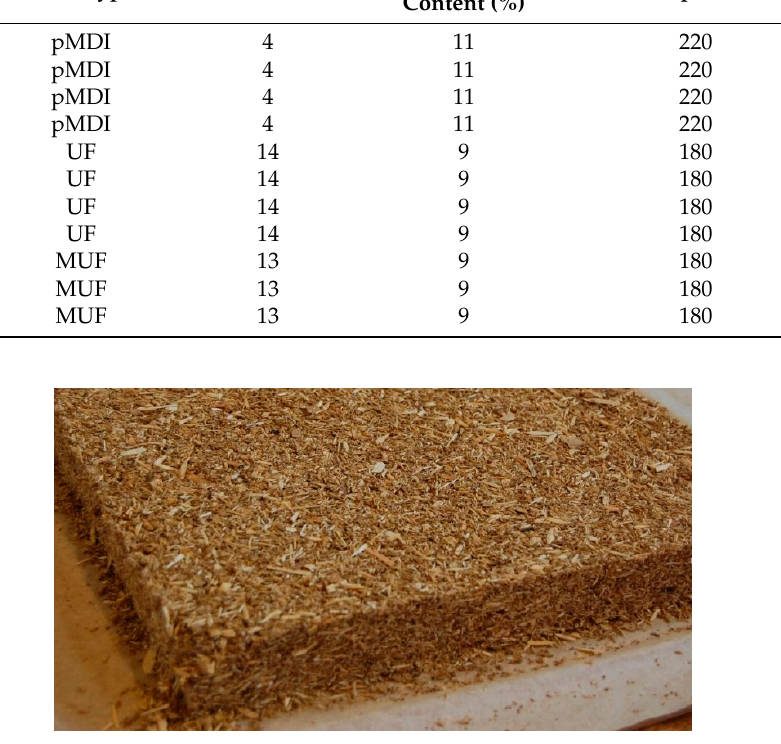
Figure 1. Particleboard matt single layered with 50% BSG after forming before hot pressing. The selected grain size for all BSG types was 2–4 mm and >4 mm. For MUF and UF 2% ammonium sulphate hardener was added. Table 1. Experimental design for the PB with BSG bonded with pMDI, MUF and UF.